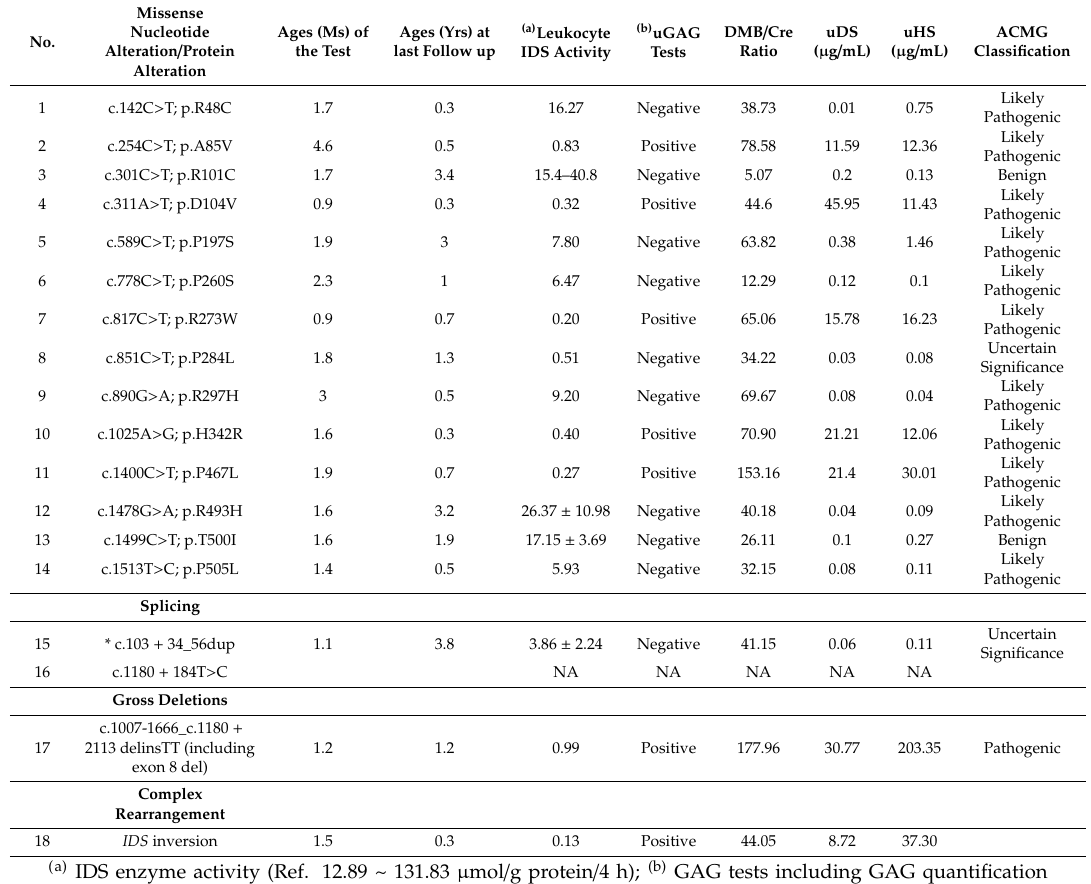
Table 2. Mutations of the iduronate-2-sulfatase ( IDS ) gene found in suspected MPS II infants referred from newborn screening program for MPS in